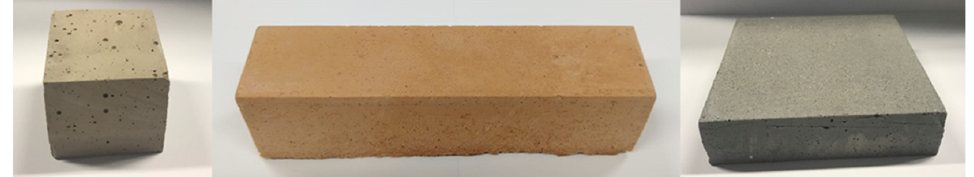
Figure 2. Examples of geopolymer test specimens: cube for determination of compressive strength ( left ), prism for determination of flexural strength ( middle ), and plate for determination of thermal conductivity and bulk density ( right ).